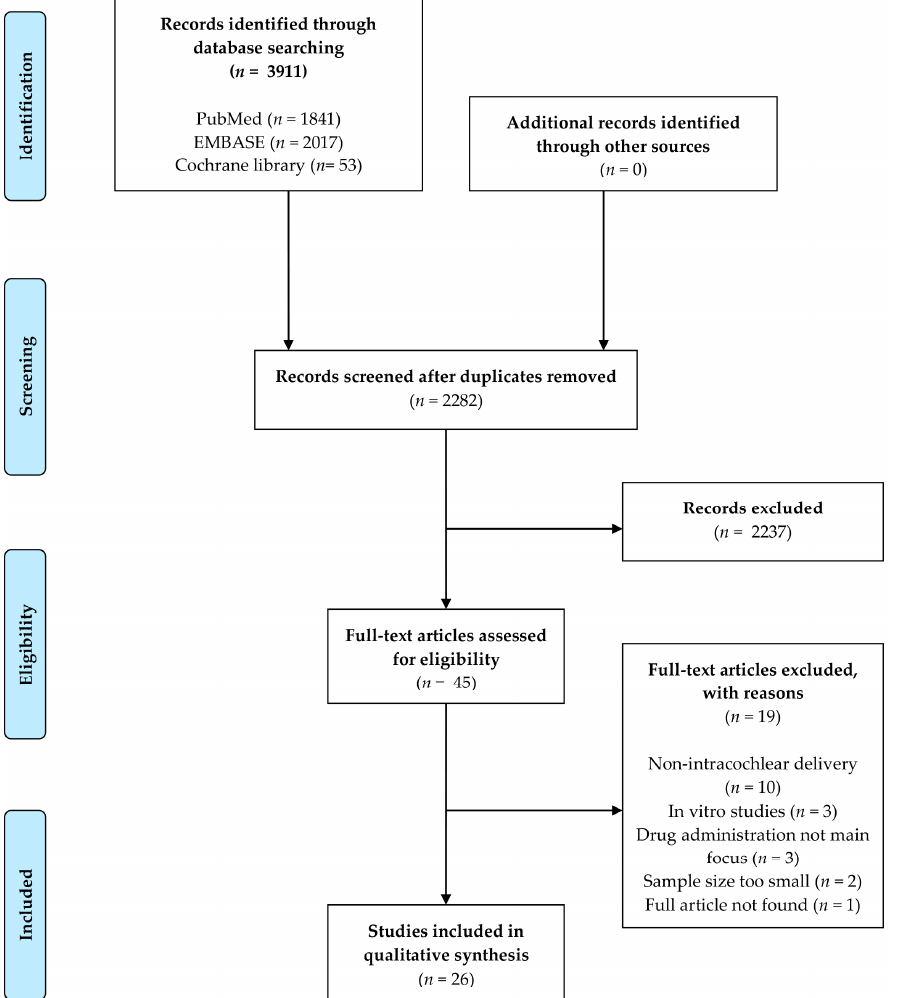
Figure 1. PRISMA Flow Diagram for Study Selection . Table 1. Study characteristics.